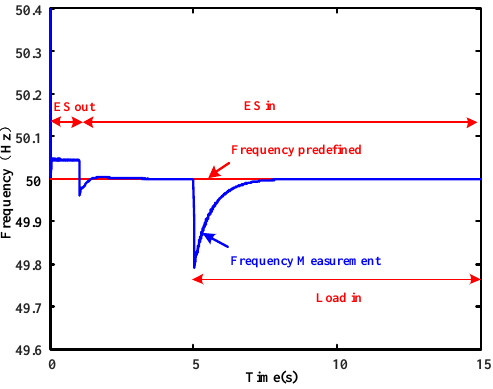
Figure 14. Simulation results of frequency responses with three ESs under the proposed control.